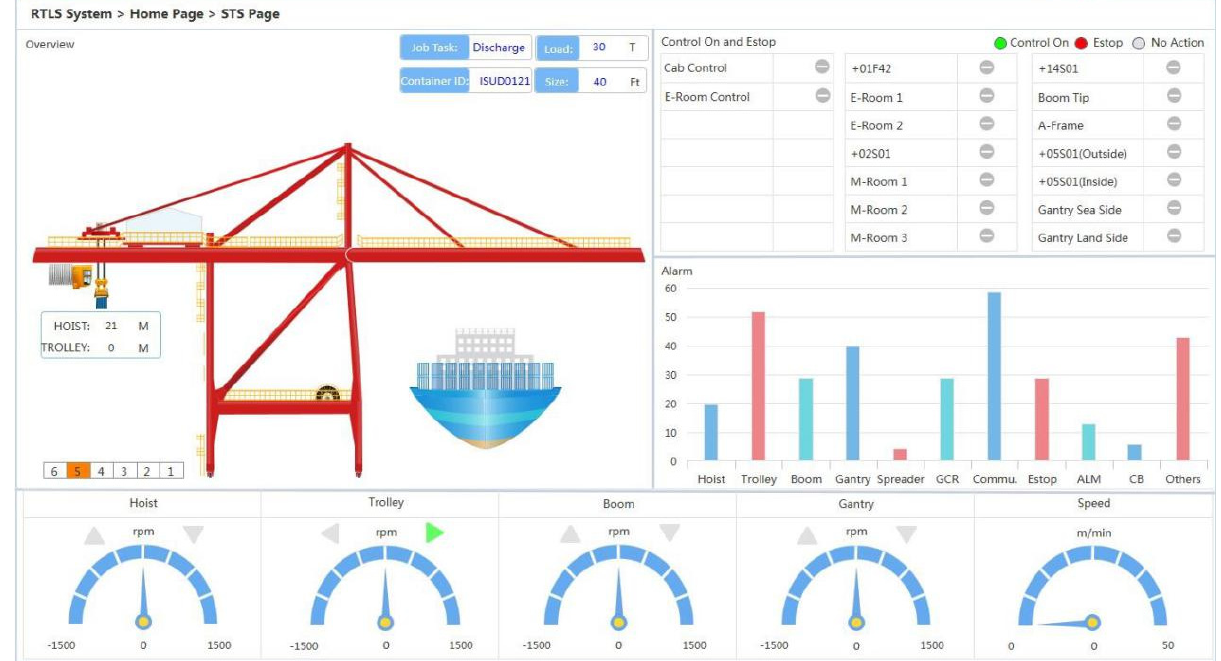
Figure 2. Crane Monitoring Interface.